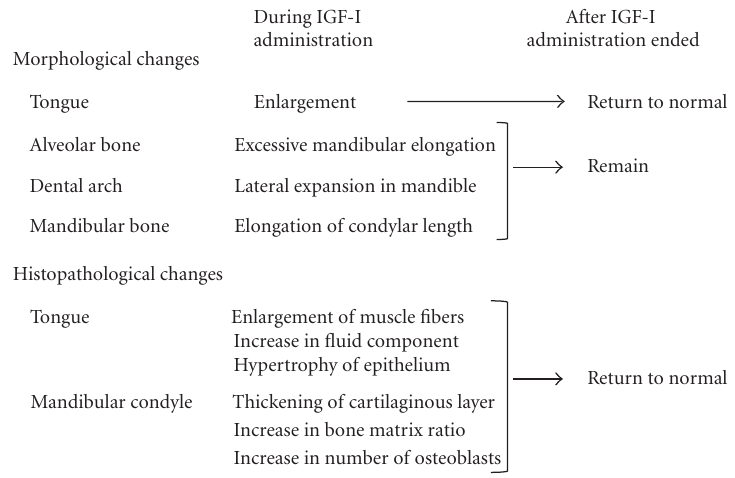
Figure 9: Changes in orofacial structures during and after IGF-I